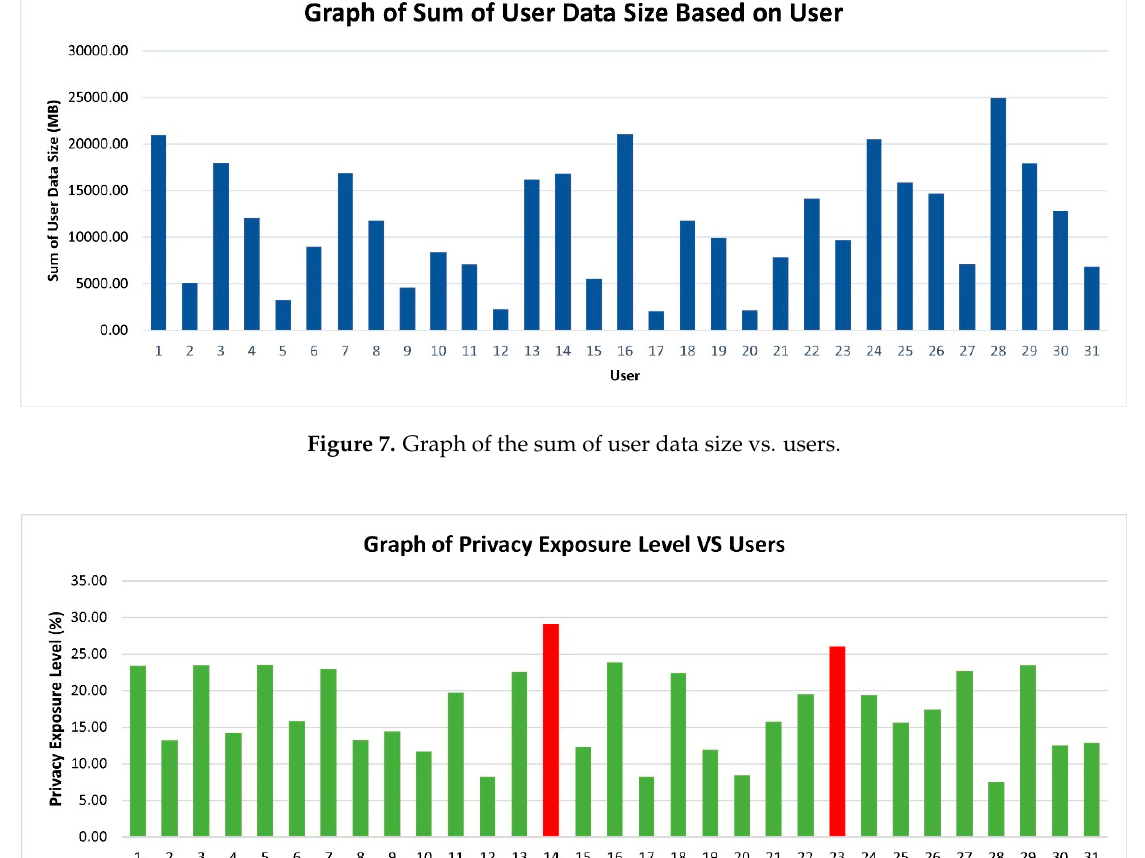
Figure 7. Graph of the sum of user data size vs. users.